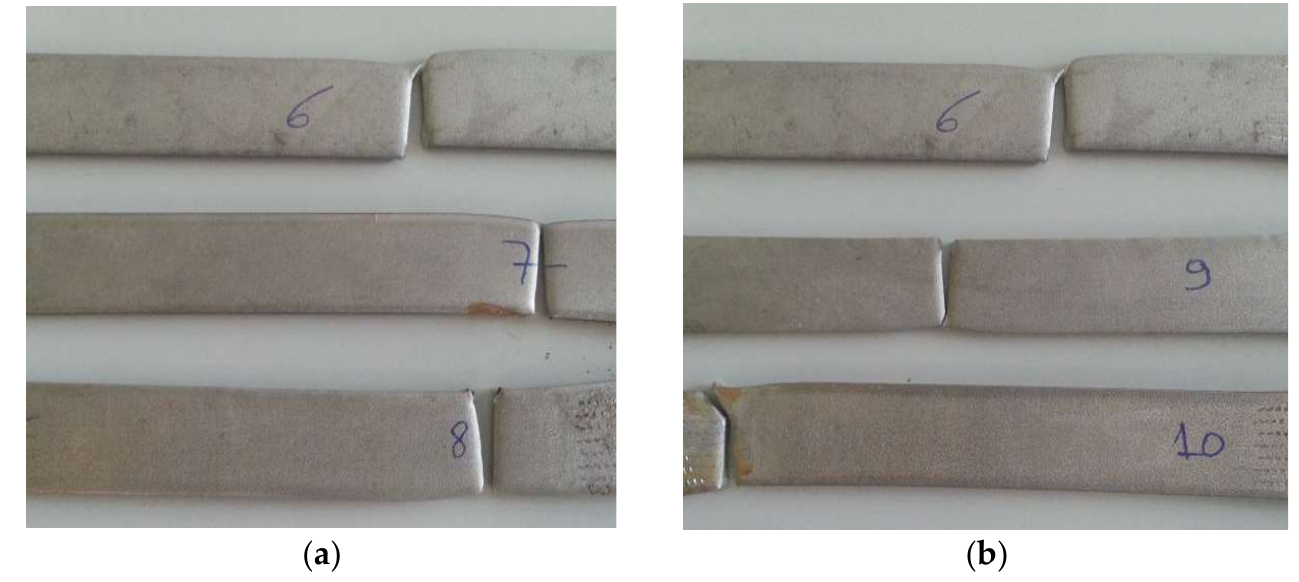
As for the AISI 321, Figure 12 shows the three specimens at three weeks (a) and three months of immersion (b) after the tensile test: standard sample at the top, 5% NaClO in the middle and 100% NaClO at the bottom.